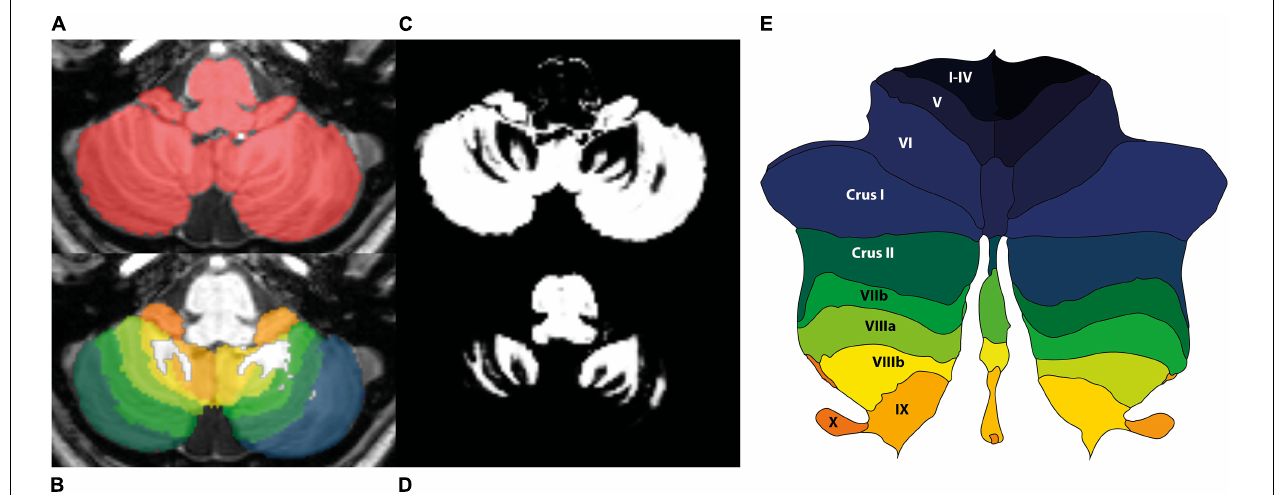
FIGURE 2 | Sample images from one of the participants obtained with the SUIT pipeline. (A) Hand-corrected isolation map of the cerebellum in native space. (B) Cerebellum overlayed with lobular map in native space. (C) Tissue probability map gray matter in native space. (D) Tissue probability map white matter in native space. (E) Probabilistic lobular atlas of the regions of interest on a flatmap of the cerebellum. The colors correspond to the colors in panel (B)